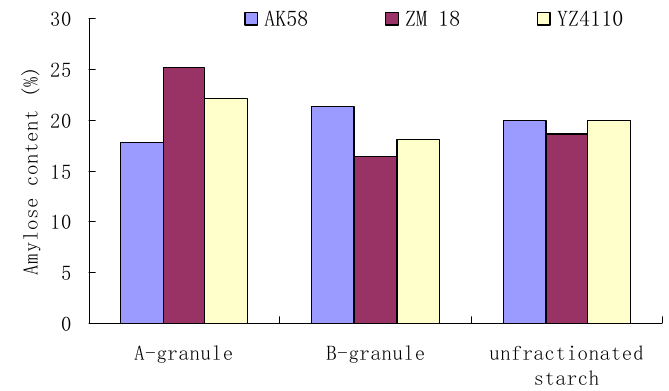
Figure 3. Amylose content of wheat starches and their A- granules and